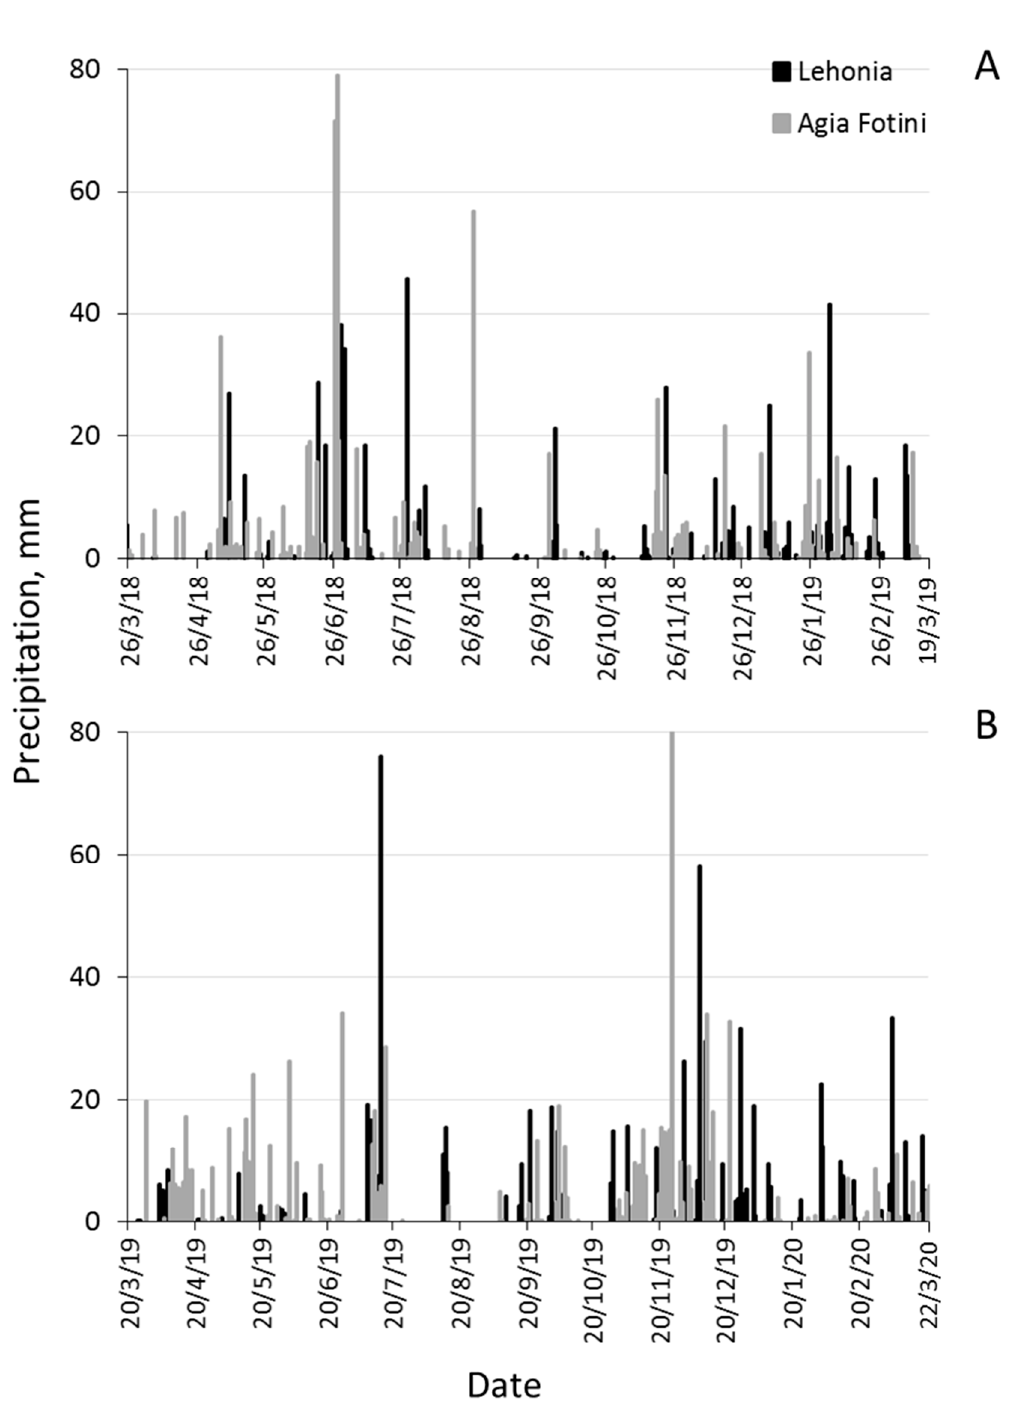
Figure 2. Seasonal patterns of daily precipitation levels in Lehonia and Agia Fotini from 26 March